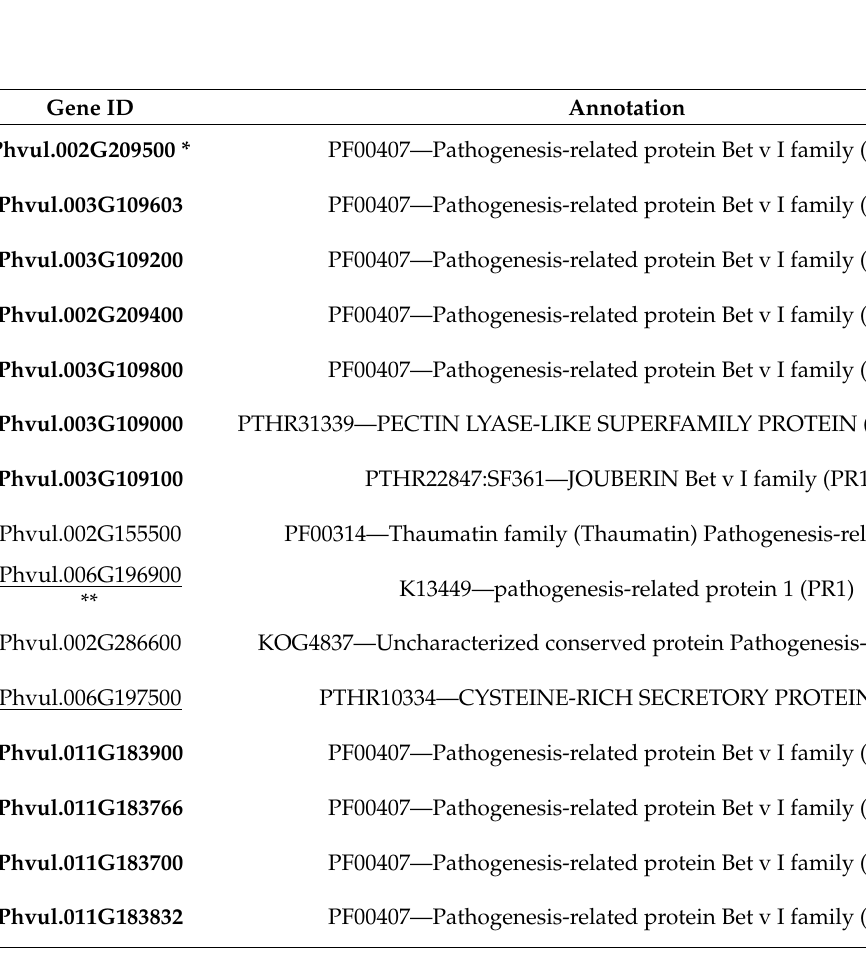
Incompatible Compatible C531 vs. Mock C531 vs. Mock Strain 100 vs. Strain 100 vs. 48 hpi 72 hpi Mock 48 hpi Mock 72